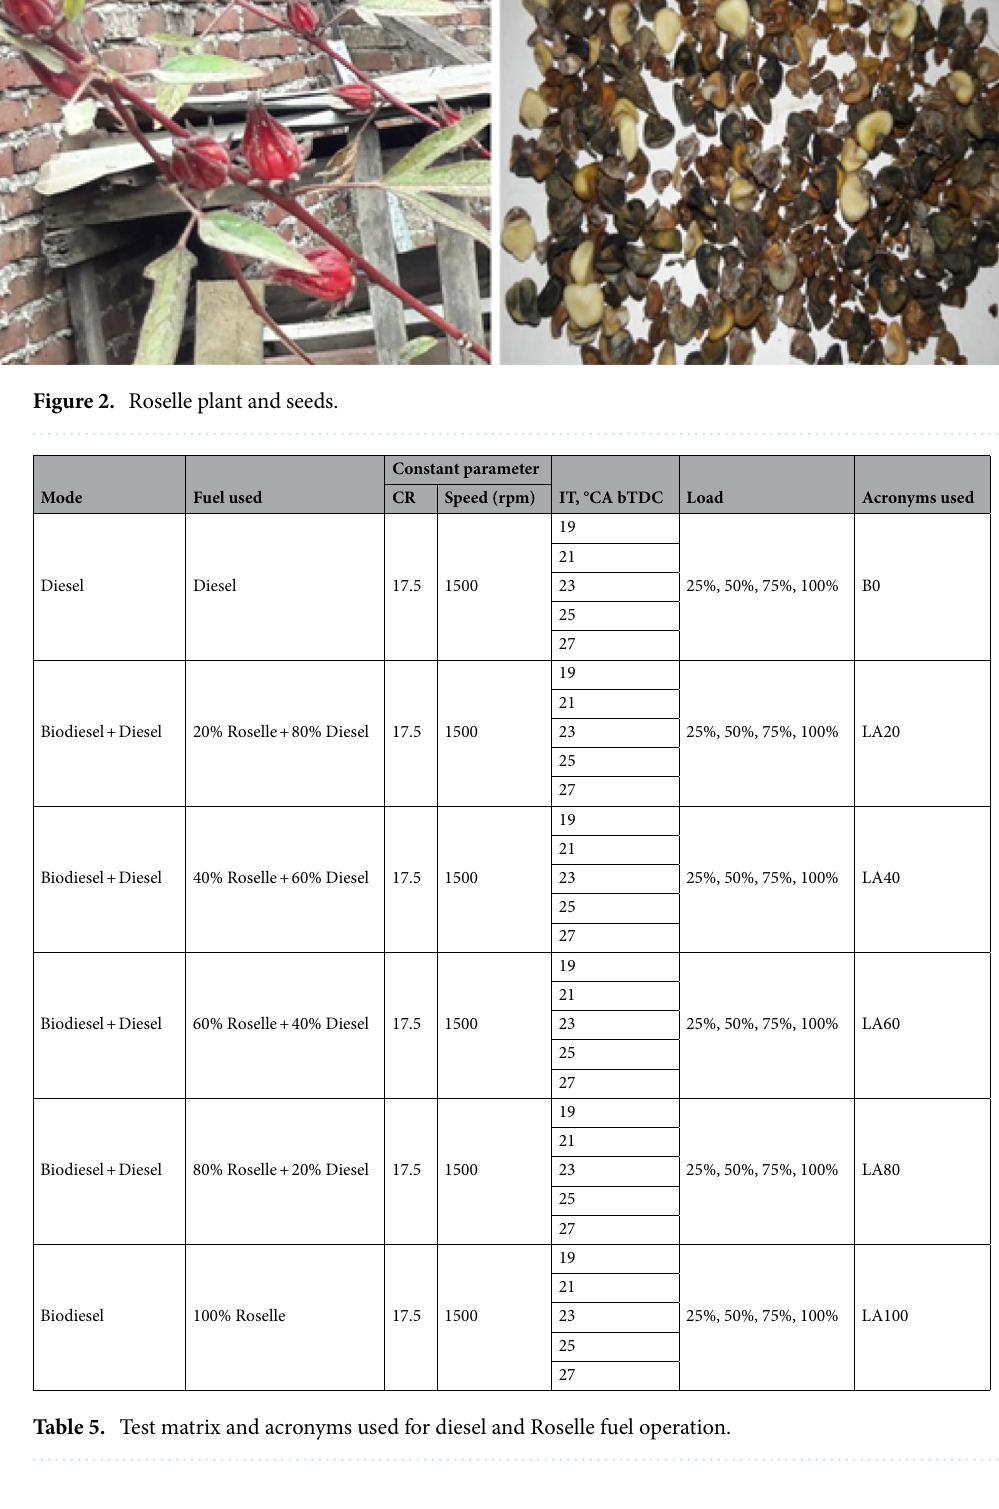
Table 5. Test matrix and acronyms used for diesel and Roselle fuel operation.